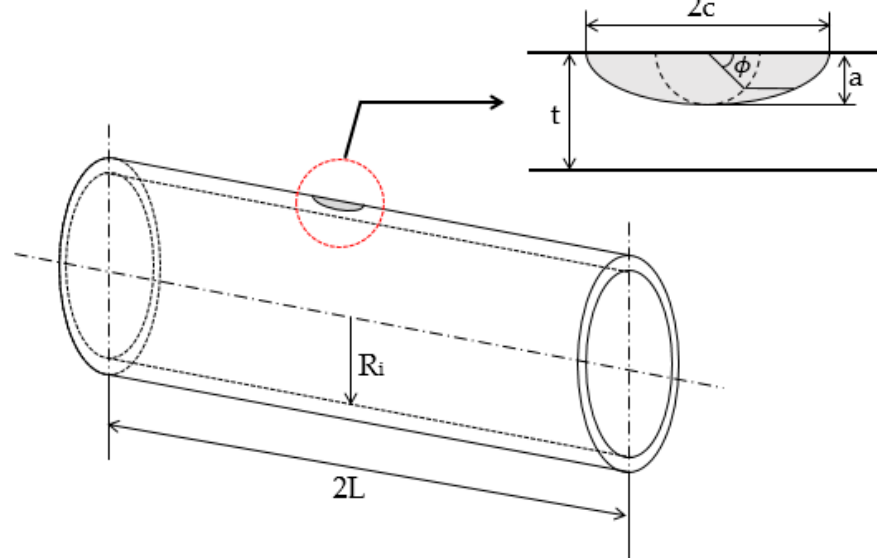
Figure 3. Hollow cylinder geometry with semielliptical surface crack at the external surface in the axial direction. Table 2. Geometric parameters for hollow cylinder. Data taken from Ramos [11].